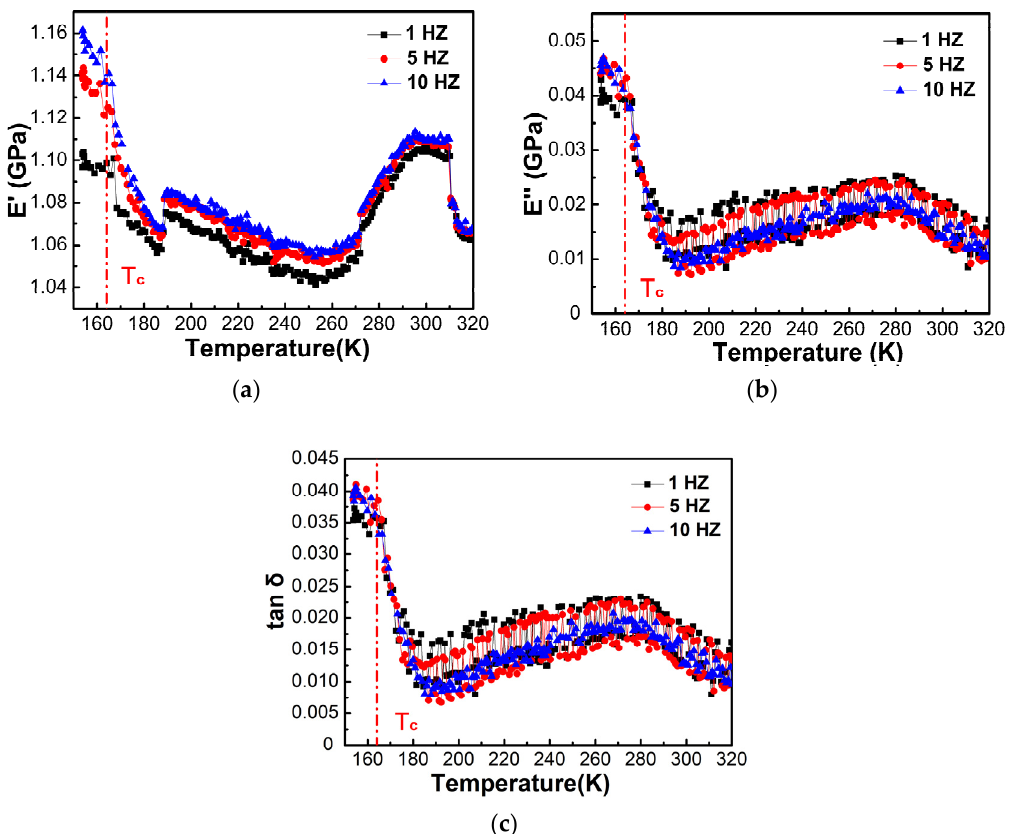
Figure 6. Temperature dependences of ( a ) storage modulus, E’, ( b ) loss modulus, E’’, and ( c ) loss factor tan δ of [(CH 3 ) 2 NH 2 ][Fe(HCOO) 3 ] single crystals at frequencies of 1–10 Hz determined by DMA during heating at the rate of 2 K/min. The vertical dash-dotted line indicates the ferroelectric transition temperature T c ~ 164 K. For [(CH 3 ) 2 NH 2 ][Fe(HCOO) 3 ] pellets, the storage modulus was ~55 MPa, the loss modulus was ~3.5 MPa, and the loss factor was ~0.065 near 298 K. Figure 7 shows the